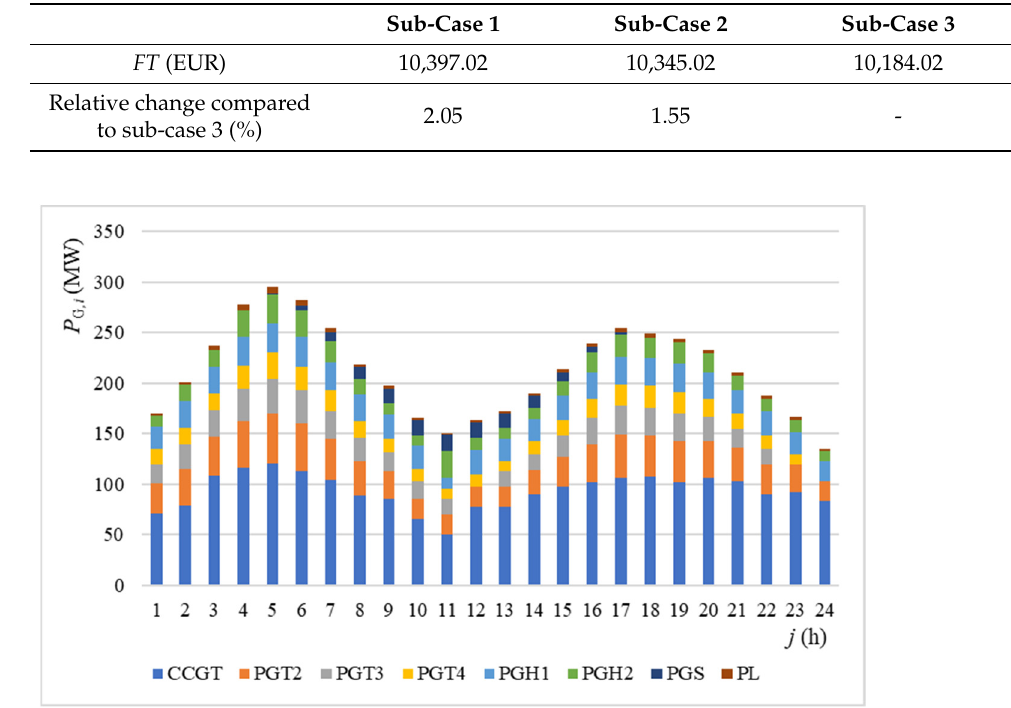
Figure 12. Optimal generation scheduling for case 2–sub-case 1.